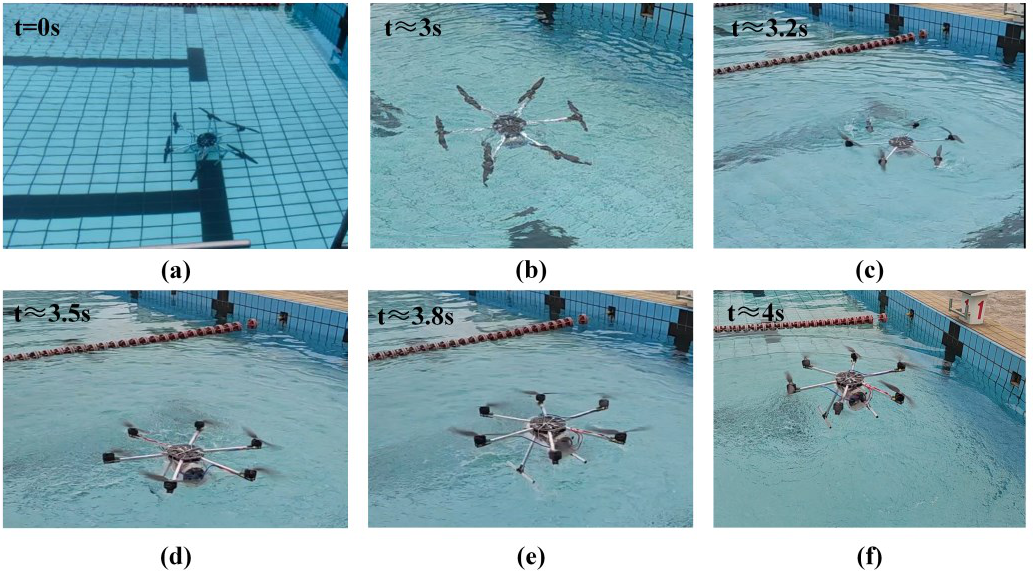
Figure 9. Diagram of the out-of-water motion process: ( a ) 1 m underwater ( b ) from underwater near the horizontal ( c ), ( d ) transition ( e ) 0–1 m in air ( f ) 1 m in air.